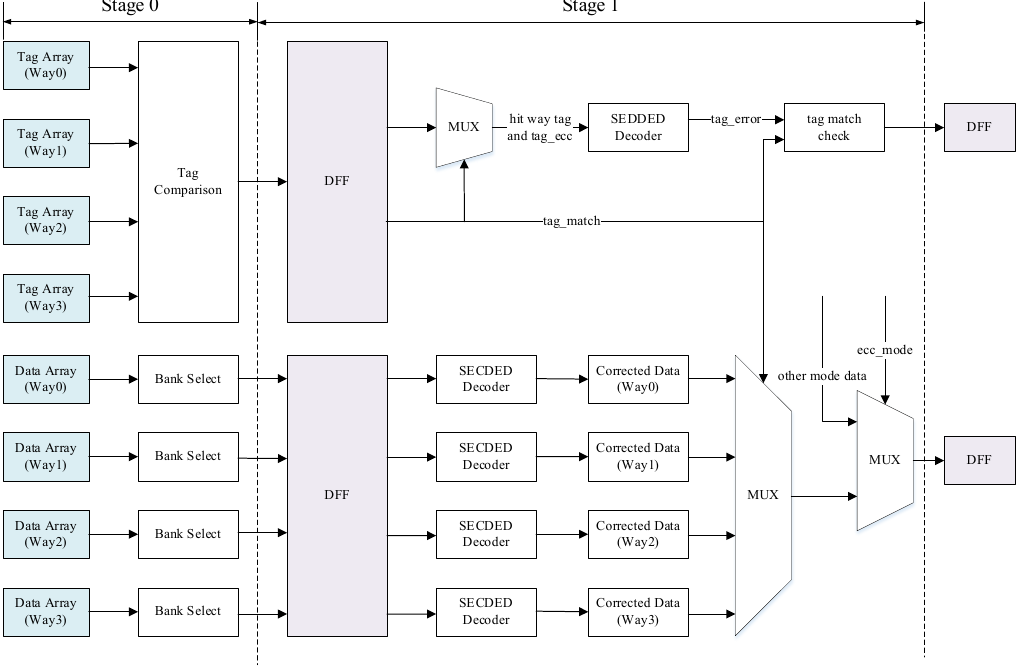
Figure 2. Proposed high-performance design scheme with ECC protection in the cache.